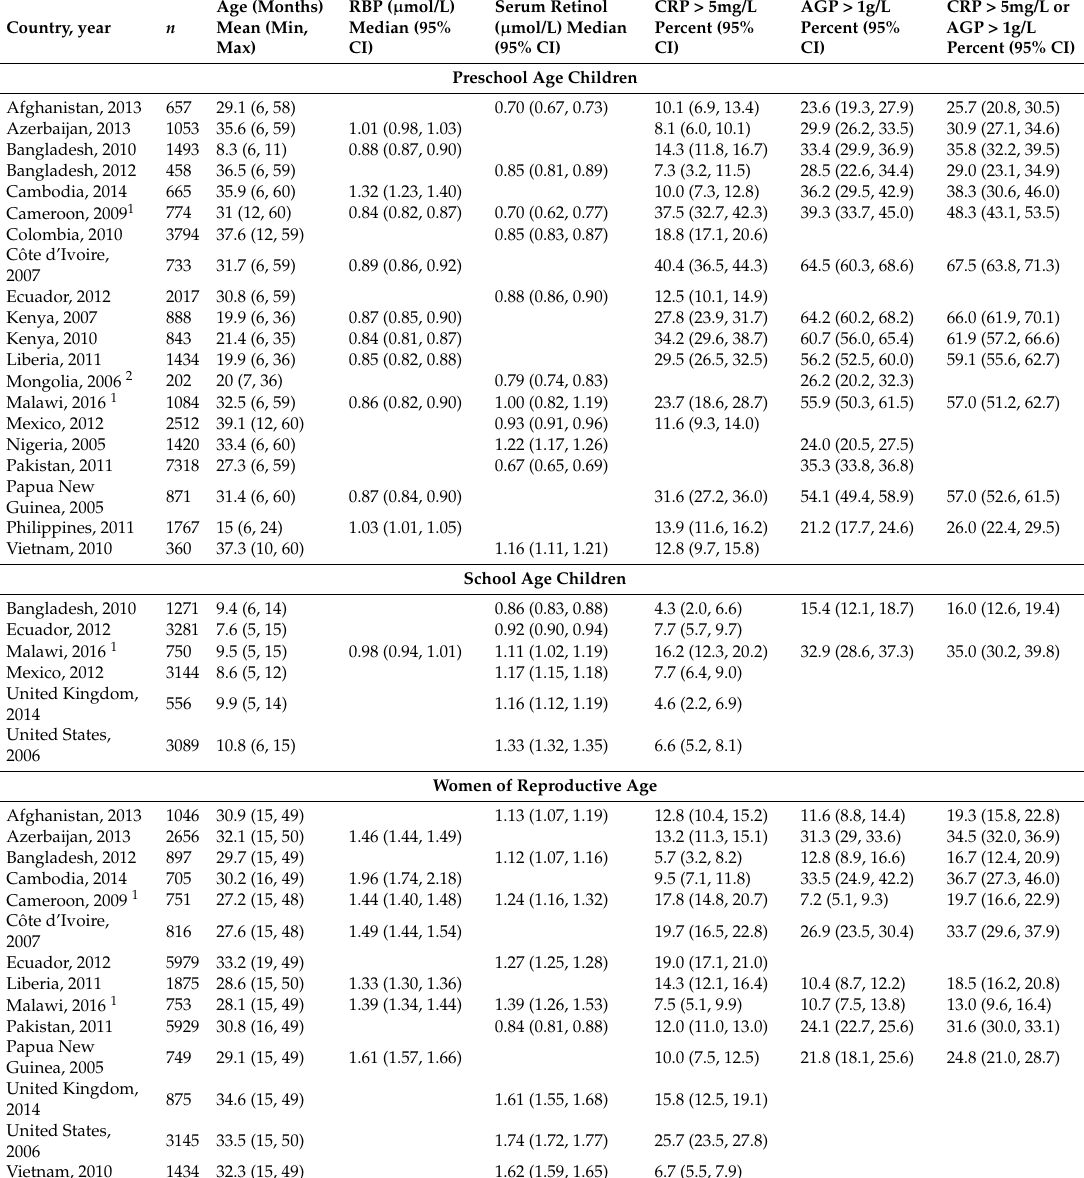
Table 1. Age, inflammation, vitamin A status, and malaria among preschool age children, school age children, and women of reproductive age, Biomarkers Reflecting Inflammation and Nutritional Determinants of Anemia (BRINDA)